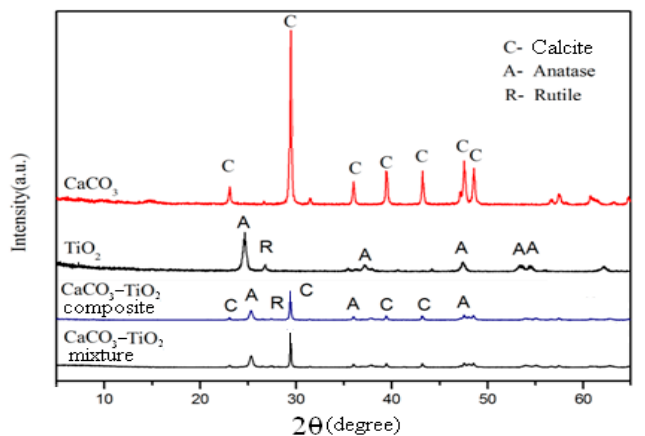
Figure 7. X-ray diffraction (XRD) spectra of CaCO 3 , TiO 2 , CaCO 3 –TiO 2 composite and the physical mixture of CaCO 3 and TiO 2 .